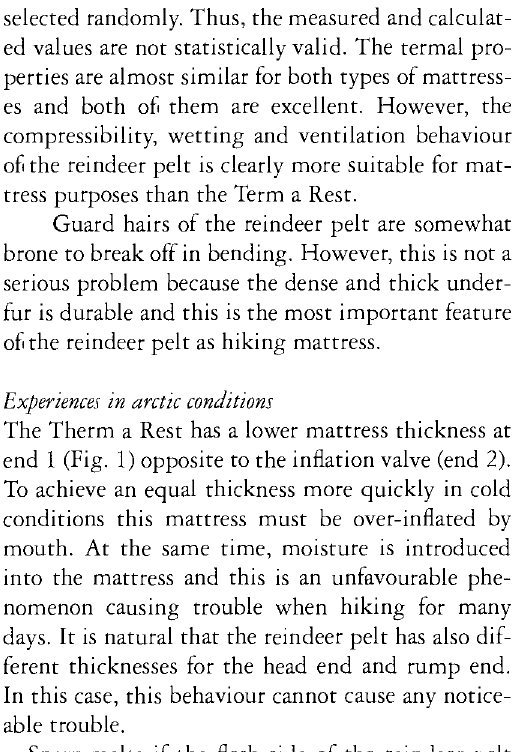
Fig. 6. R-value, R, versus temperature difference,